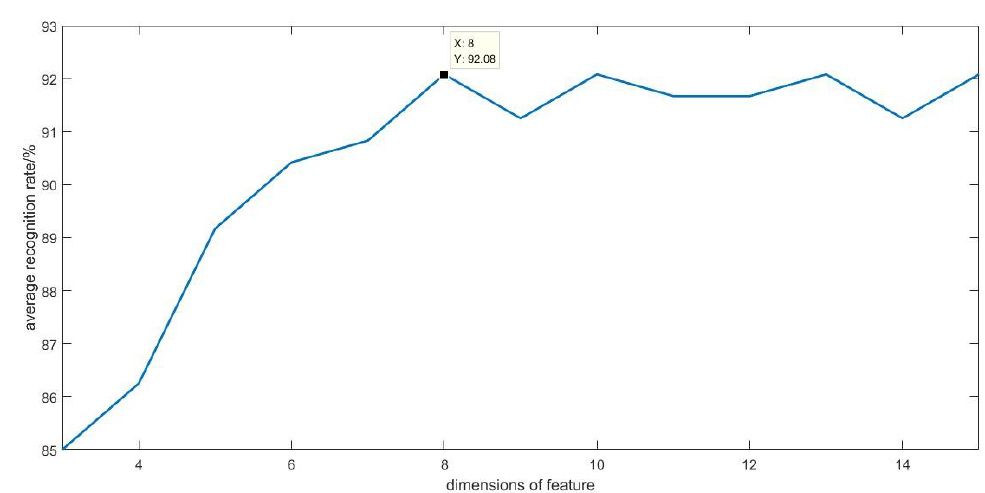
ff erent dimensions of